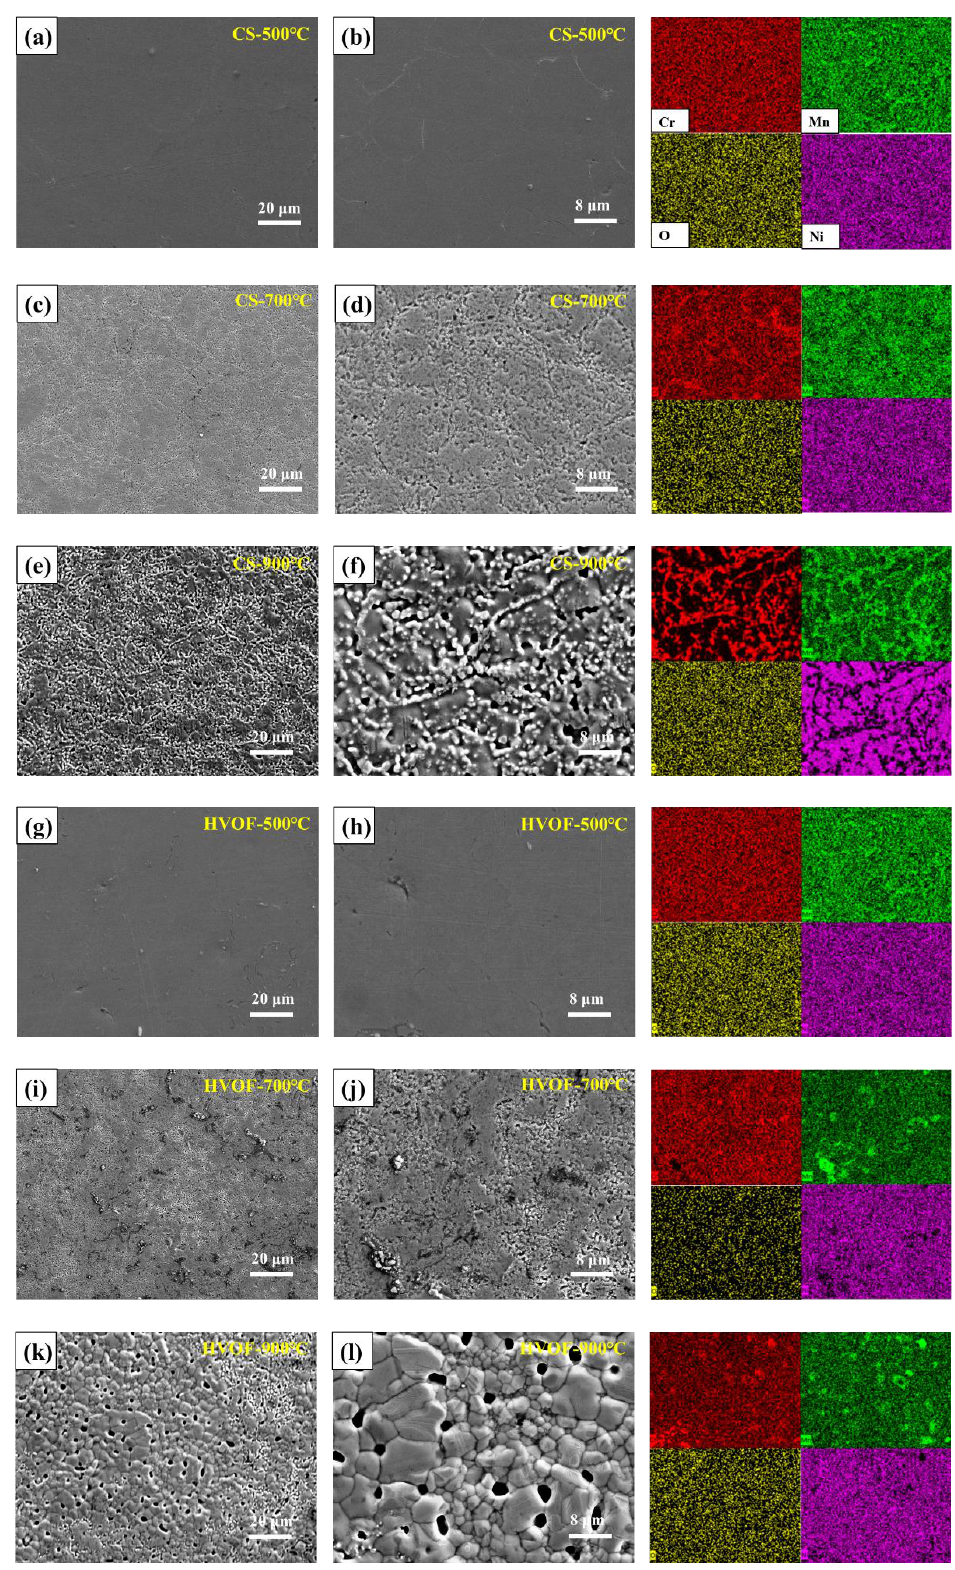
Figure 8. Surface morphology and energy spectrum of CS and HVOF coatings heat-treated at different temperatures. ( a , b ) CS-500°C; ( c , d ) CS-700°C; ( e , f ) CS-900°C; ( g , h ) HVOF-500°C; ( i , j ) HVOF-700°C; ( k , l ) HVOF-900°C.